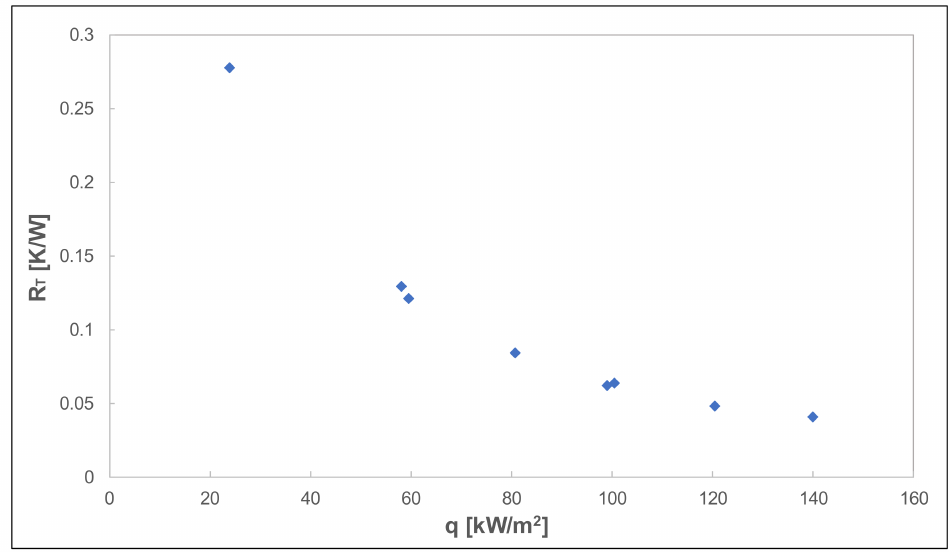
Figure 7. Thermal resistance of the CLTPT vs. heat flux.